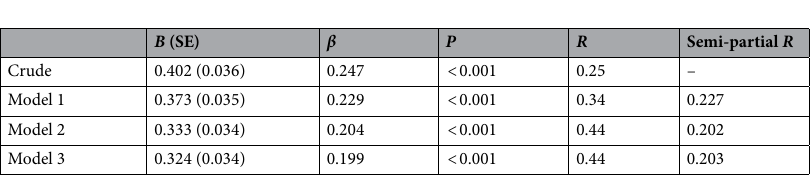
Table 2. Multiple regression analyses results of health literacy and purpose in life. SE, standard error; B, unstandardized regression coefficients; β , standardized regression coefficients, R : coefficient of multiple regression, semi-partial R : semi-partial coefficient of health literacy in the multiple regression models. Model 1 adjusted for age, sex, income, education, and marital status; Model 2, psychological stress; Model 3, status of diabetes mellitus, hypertension, dyslipidemia, cancer, and obesity, respectively.